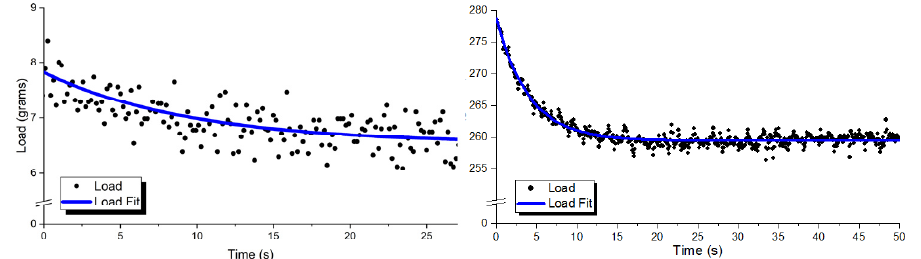
Figure 9. Viscoelastic stress relaxation observed in PVC gel samples when undergoing stepped compressive strain input (black) and SLS model fit (blue) for low ( left ) and high ( right ) compressive loading applications.